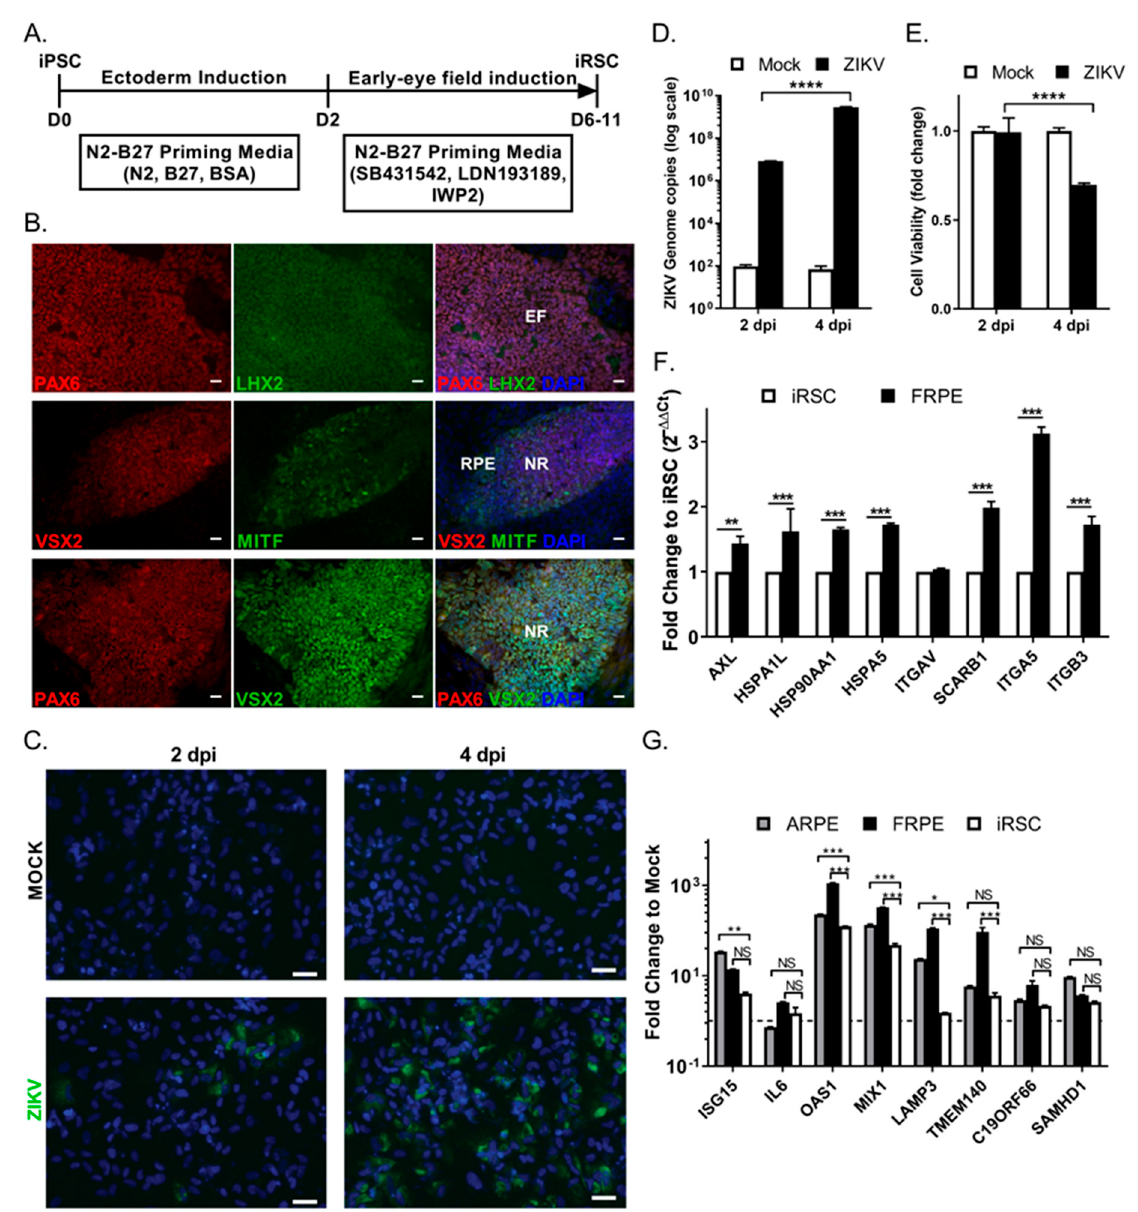
Figure 5. iPSC-derived retinal stem cells show reduced susceptibility to ZIKV infection ( A ) Schematic diagram showing the experimental outline used for the differentiation of human derived iPSCs into iRSCs. ( B ) Differentiated iRSCs show the expression of early eye stem cell transcription factors PAX6, LHX2, VSX2/CHX10 (neural retina; NR) and MITF (RPE) at day 11. Nuclei stained with DAPI. Scale bar: 30 µ m. EF: eye field. ( C ) Immunofluorescence images of mock and ZIKV-infected iRSCs (viral Env protein, green) at 2 (left panels) and 4 (right panels) dpi. Nuclei stained with DAPI (blue). Scale bar: 25 µ m. ( D ) Graph shows the quantification of ZIKV genome copies in mock and ZIKV infected iRSCs at 2 and 4 dpi. ( E ) Viability of uninfected and infected iRSCs at 2 and 4 dpi. The fold change to mock is shown. ( F ) Fold change in flaviviral entry receptor expression in fetal RPE cells relative to iRSCs. RT-qPCR Ct cycles for each gene were normalized to housekeep- ing gene GAPDH. The calculated 2 - ΔΔ Ct values are presented in the bar graph as fold change. Student t-test was performed ( G ) Comparative analysis of inflammatory and innate immune genes induced by ZIKV infection of fetal RPE (FRPE), adult RPE (ARPE), and iRSCs. Two-way ANOVA followed by Bonferroni test was performed for statistical significance if the p value was p < 0.05 (*); p < 0.001 (**); p < 0.0001 (***) and p < 0.00001 (****), and ns, no significance. Representative data from three independent experiments are shown.